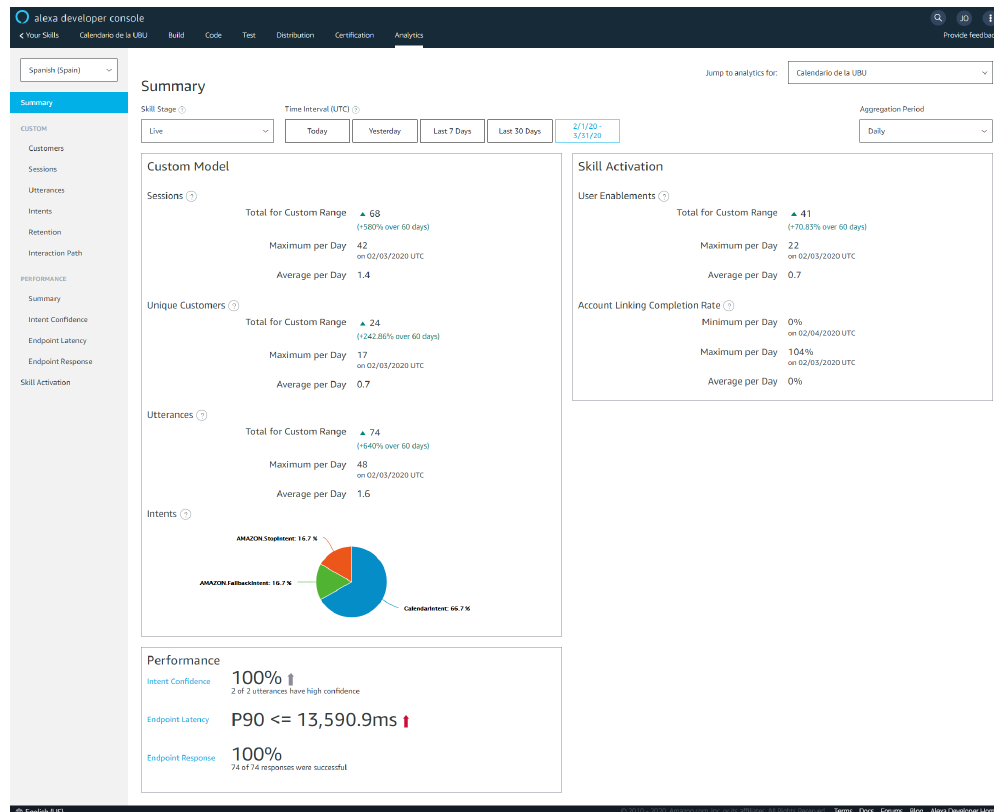
Figure 8. Screenshot of the Analytics section within the Alexa Developer Console.